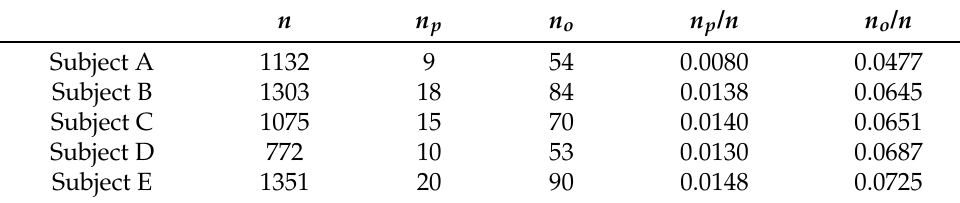
Table 9. Values of n p / n and n o / n from change score using FET “happiness” data. n n p n o n p / n n o / n